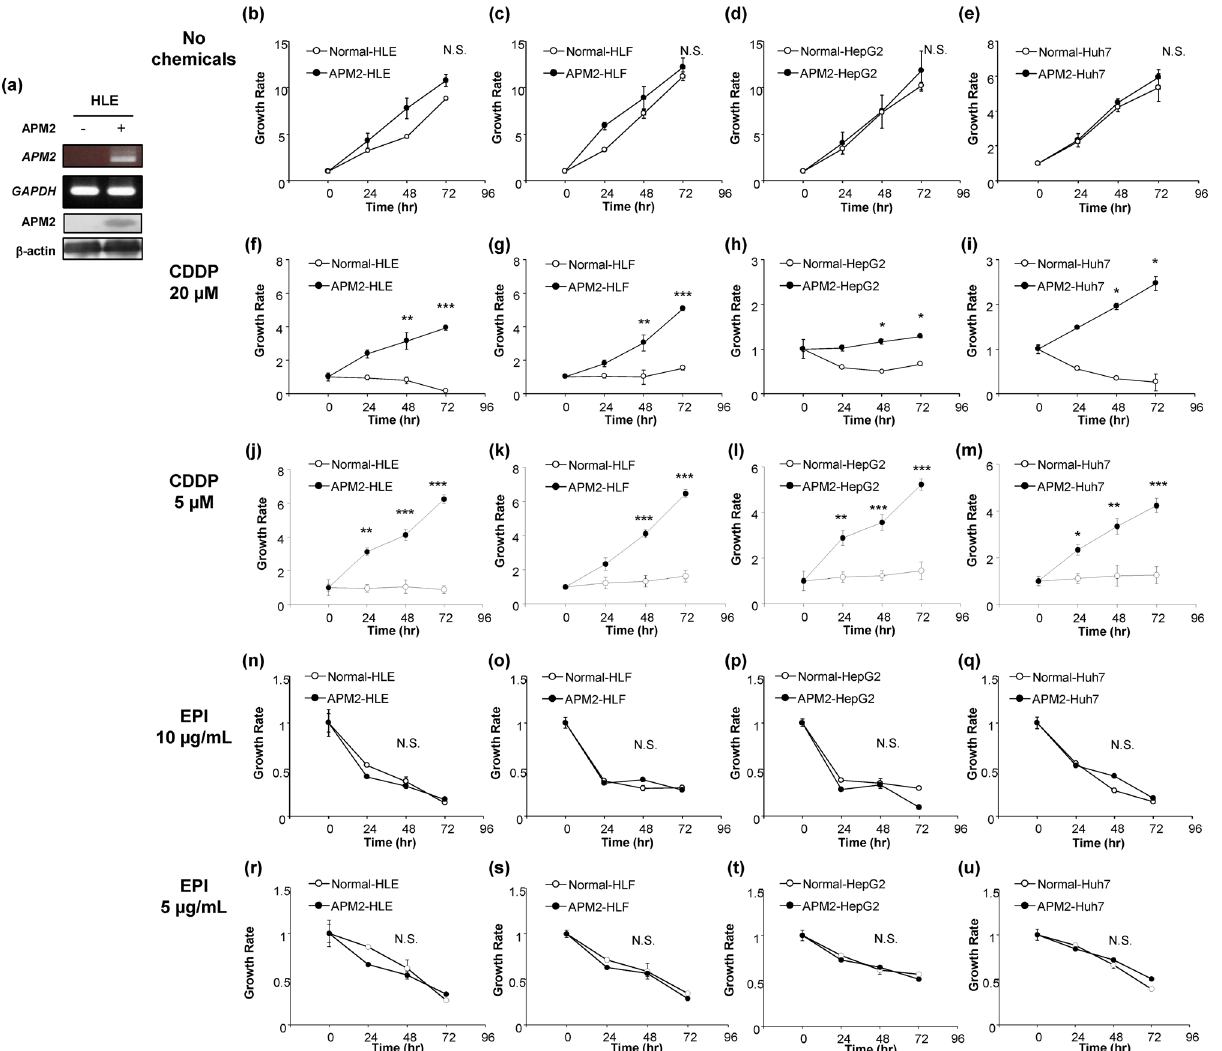
Figure 2. Effect of APM2 expression in HCC cells on the CDDP sensitivity. ( a ) The development of adipose most abundant 2 (APM2) overexpressing hepatocellular carcinoma (HCC) cell lines. Representative reverse transcription polymerase chain reaction (RT-PCR) of APM2 and glyceraldehyde 3-phosphate dehydrogenase ( GAPDH ), and Western blotting of APM2 and β-actin in APM2 overexpressing HLE. The images were grouped from the different gels and separated with the spaces. The cell growth of HCC cell lines and the permanent clones overexpressing APM2 determined the cell growth assay. ( b – e ) Cell growth of cell lines with no chemicals. ( f – i ) Cell growth with CDDP of 20 µM and ( j – m ) 5 µM. ( n – q ) Cell growth with epirubicin (EPI) of 10 µg/mL and ( r – u ) 5 µg/mL. The values are expressed as mean ± standard deviation (n = 5 for each group at time points). * p < 0.05, ** p < 0.01, *** p < 0.001, and NS, no statistical significance. Two-way analysis of variance followed by Bonferroni’s multiple comparisons